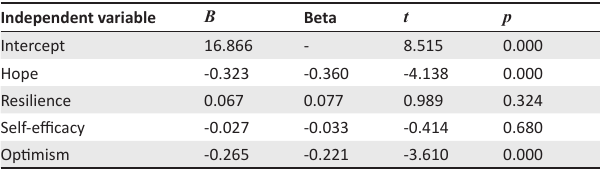
TABLE 11: Results of multiple regression with intention to quit as a dependent variable and subscales of psychological capital as independent variables.